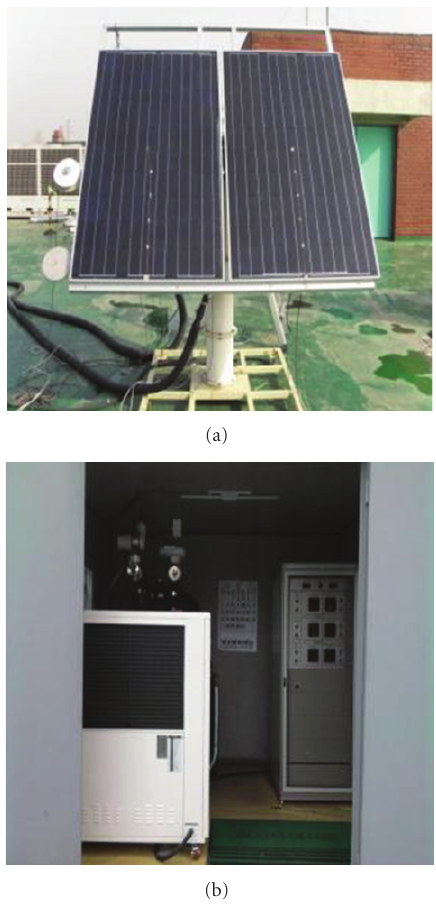
Figure 4: View of two types of PVT collector (a) in the experiment and the measuring equipment